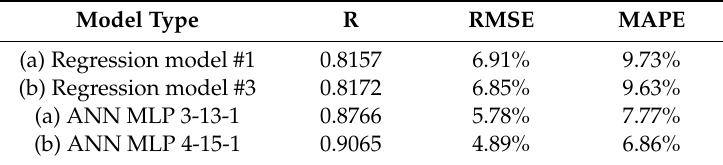
Table 8. Comparisons of the statistical values of the prediction